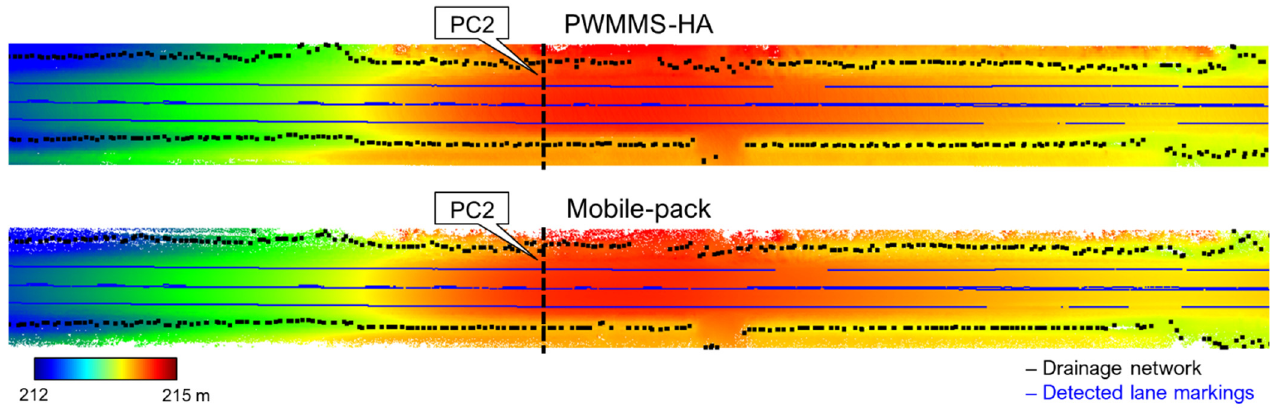
Figure 19. Drainage network (in black) together with detected lane markings (in blue) superimposed on the bare earth point cloud (colored by height).